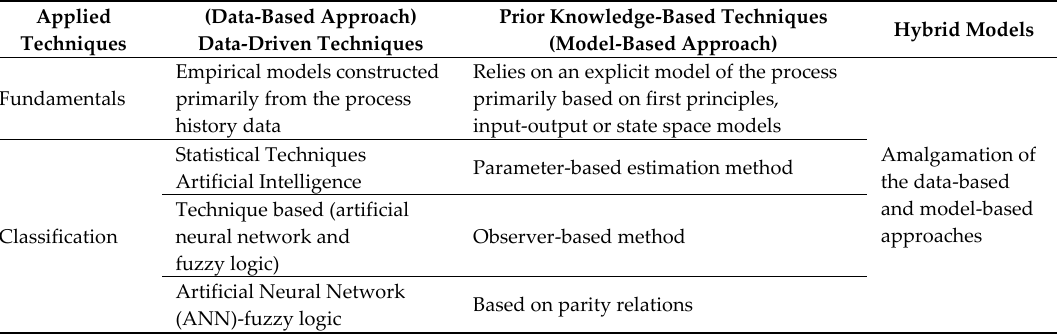
Table 7. Techniques applied to the strategies of monitoring and fault detection.